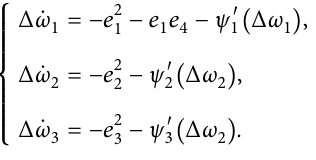
Figure 8: Typical dynamic behavior of the chaotic financial system: (a) projection in ( x projection in ( x